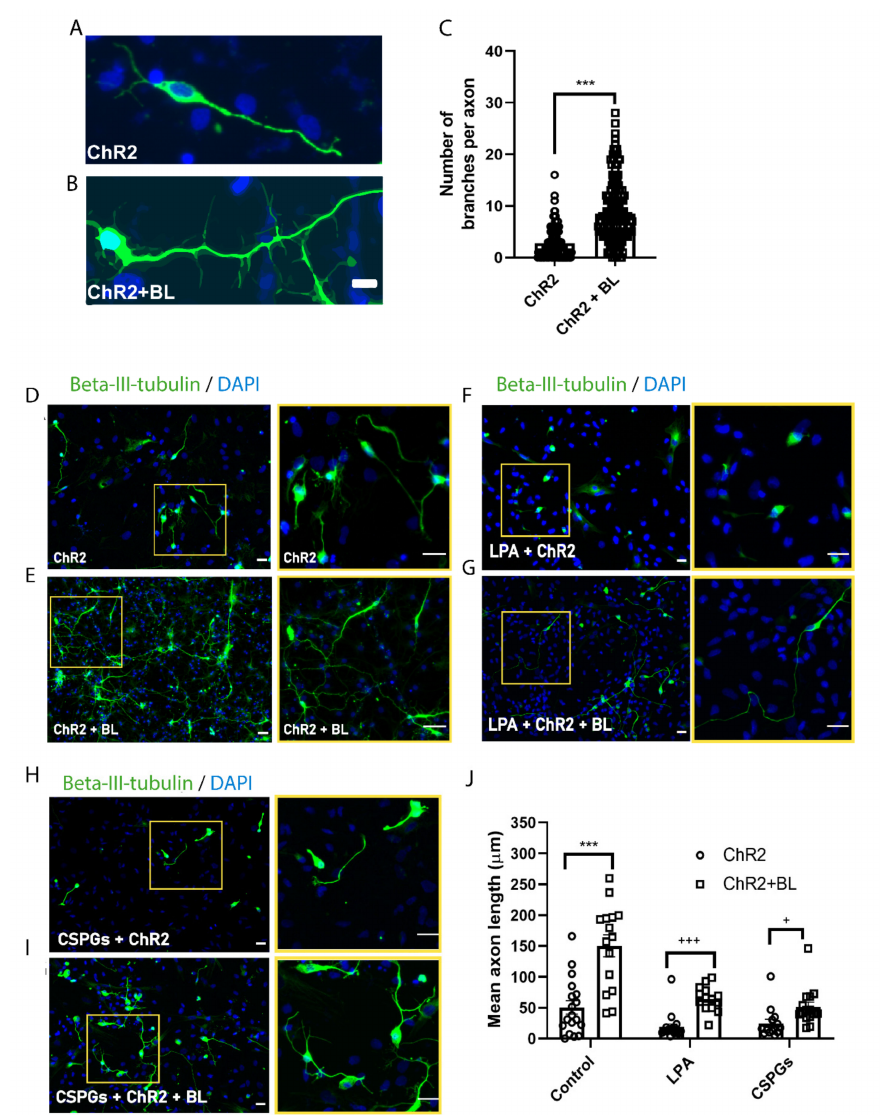
Figure 5. ChR2 activation promotes axonal branching and growth in ChR2-NPC-derived neurons and counteracts pharmacologically-induced axonal retraction. ( A , B ). Representative images of immunofluorescence staining for beta- III-tubulin (green) and nuclear detection by DAPI (blue) in unstimulated ChR2-NPCs (ChR2) (A) and BL-stimulated ChR2-NPCs (ChR2 + BL) (B). Scale bars, 10 µ M. ( C ) Quantification of branches per axon in unstimulated (ChR2) and BL-stimulated ChR2-NPCs (ChR2 + BL). Data are expressed as mean ± SEM (ChR2: 2.8 ± 0.2; ChR2 + BL: 8.5 ± 0.4). *** p < 0.001 vs. ChR2 determined by unpaired t -test. ( D , E ) Representative images of immunofluorescence staining for beta-III-tubulin (green) and nuclear detection by DAPI (blue) in unstimulated ChR2-NPCs (ChR2) (D) and in BL-stimulated ChR2-NPCs (ChR2 + BL). (E). Yellow squares show higher magnification of selected neurons. Scale bars, 20 µ M. ( F , G ) Representative images of immunofluorescence staining for beta-III-tubulin (green) and nuclear detection by DAPI (blue) in unstimulated (ChR2) (D) and BL-stimulated ChR2-NPCs (ChR2 + BL) (E) in the presence of LPA (10 µ M). Yellow squares show higher magnification of selected neurons. Scale bars, 20 µ M. ( H , I ). Representative images of immunofluorescence staining for beta-III-tubulin (green) and nuclear detection by DAPI (blue) in unstimulated (ChR2) (H) and BL-stimulated ChR2-NPCs (ChR2 + BL) (I) in the presence of chondroitin sulfate proteoglycans (CSPGs) (2 µ g/mL) at day three of differentiation. Yellow squares show higher magnification of selected neurons. Scale bars, 20 µ M. ( J ) Quantification of mean axonal length for untreated (ChR2: 50.6 ± 10.7; ChR2 + BL: 150.4 ± 17.8), LPA-treated (ChR2: 18.9 ± 4.8; ChR2 + BL: 69.7 ± 6.6), and CSPG-treated (ChR2: 24.9 ± 6.6; ChR2 + BL: 51.3 ± 8) unstimulated (ChR2) and BL-stimulated ChR2-NPCs (ChR2 + BL). Data are expressed as mean ± SEM from three independent experiments. *** p < 0.001 vs. ChR2 determined by unpaired t -test; +++ p < 0.001; + p < 0.05 vs. ChR2 determined by Mann–Whitney test. Scale bars, 20 µ